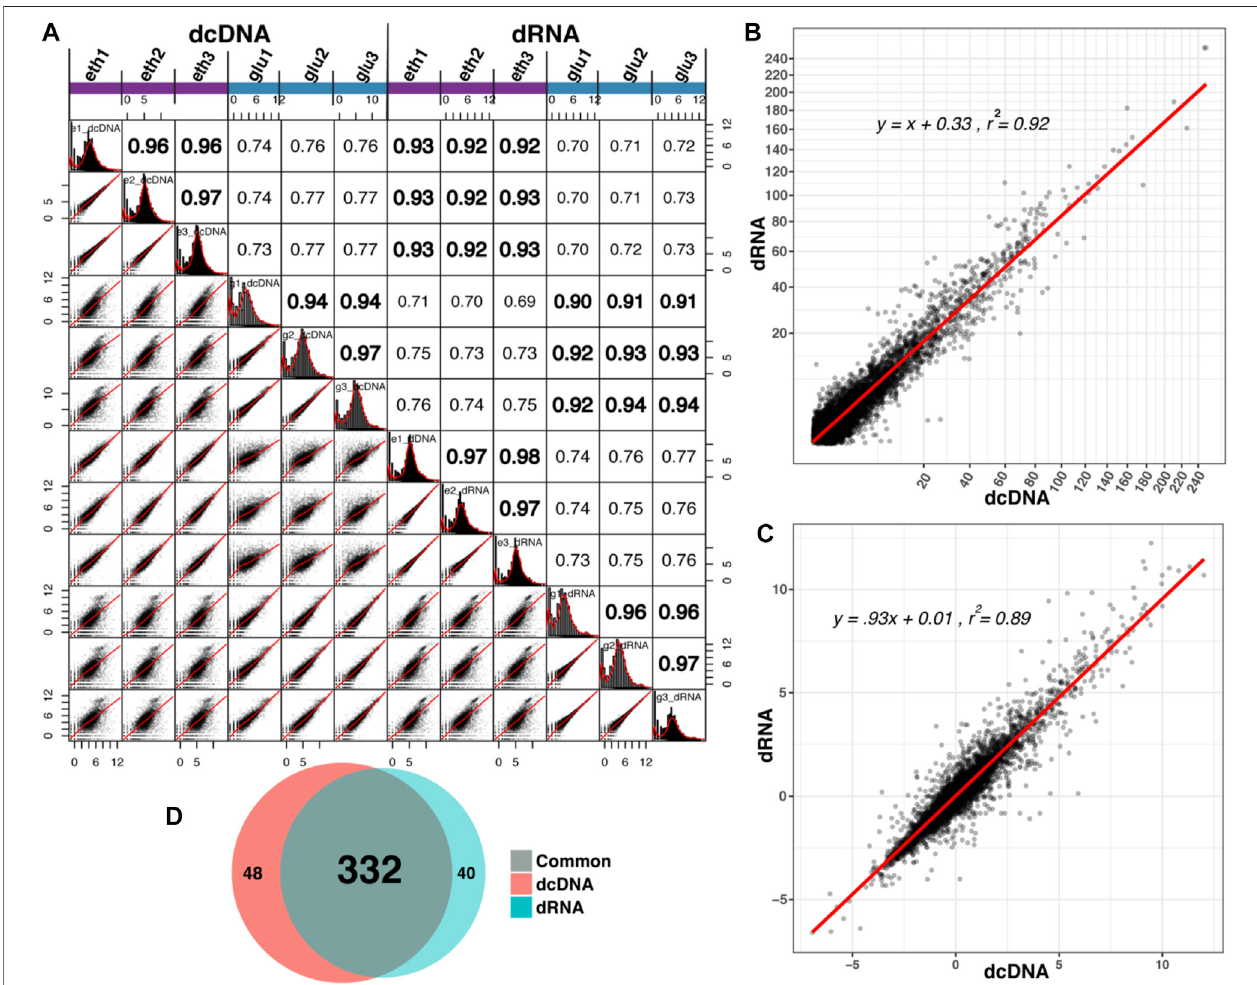
FIGURE 3 | Comparison of transcript abundances based on dcDNA-seq and dRNA-seq. (A) Combined scatter plot and correlation matrix. (B,C) Scatter plots showing the correlation of statistical values between all individual transcripts combined as identi fi ed by dcDNA and dRNA based on adjusted p -values (B) and on observed mean log2fold changes (C) derived from three biological replicates. (D) Venn diagram of GO terms identi fi ed in dcDNA and dRNA datasets.